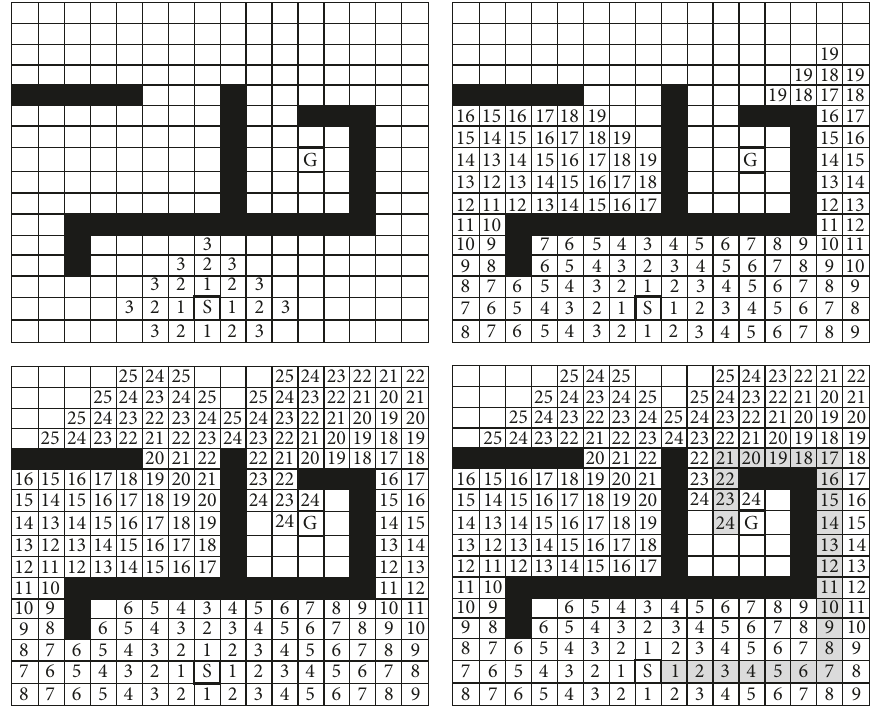
Figure 1: Dijkstra method to find the optimal path [14].